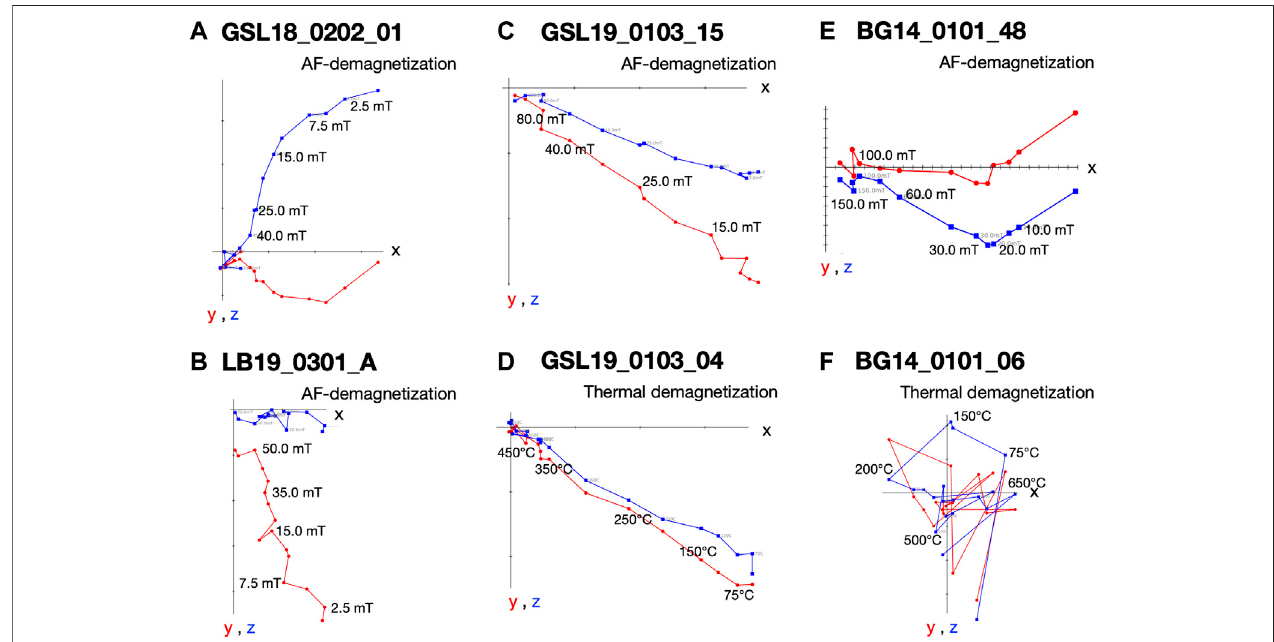
FIGURE 6 | Vector endpoint diagrams for representative microbialite specimens. (A) AF demagnetization pattern for living Antelope Island GSL microbialite specimen GSL18_0202_01 (B) AF demagnetization pattern for living lithi fi ed LB Site 3 microbialite specimen LB19_0301_A (C) AF demagnetization pattern for specimen Lakeside lithi fi ed GSL microbialite GSL19_0103_15 (D) thermal demagnetization of specimen GSL19_0103_04 (E) AF demagnetization for BG stromatolite specimen BG14_0101_48; and (F) thermal demagnetization for specimen BG14_0101_06.